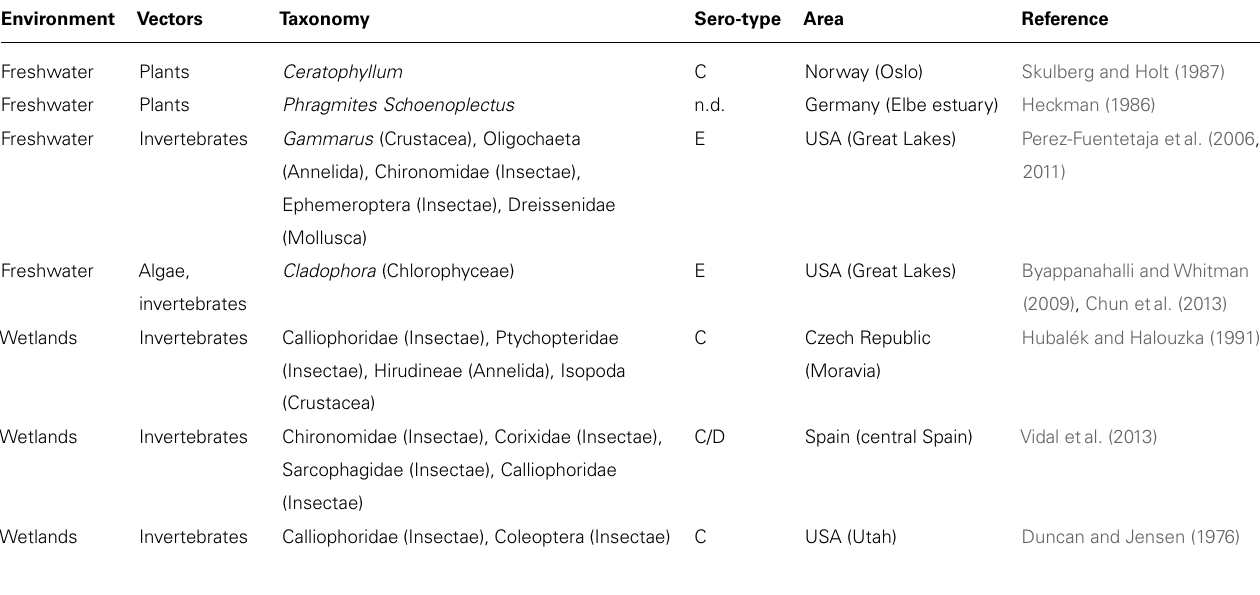
Table 1 | Clostridium botulinum and possible vector